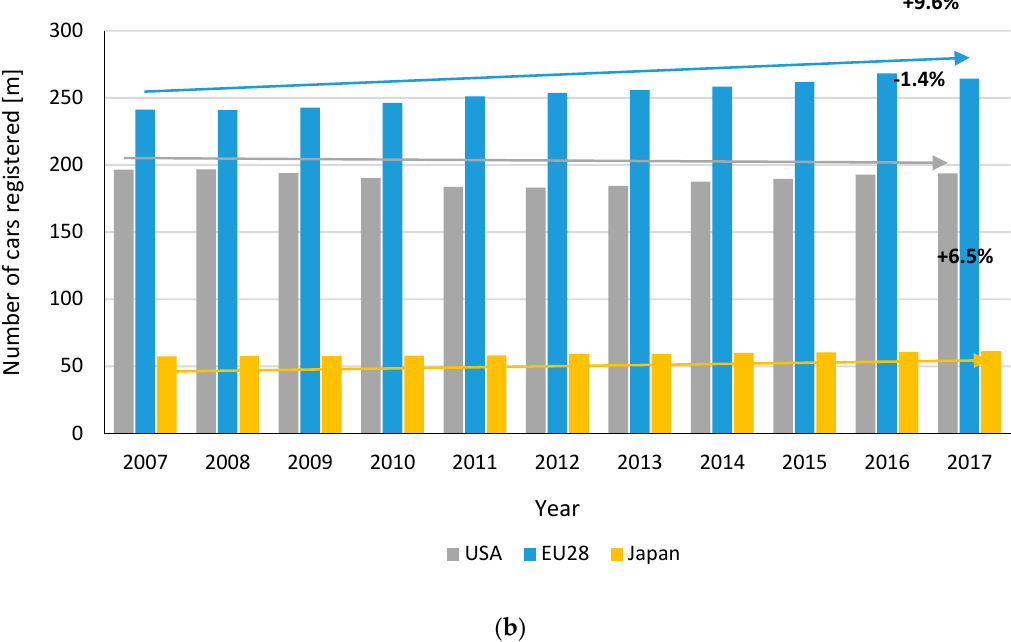
Figure 1. Motorization development in the analysed regions: ( a ) Population in the US, EU and Japan in 2007–2017 [m]; ( b ) Number of cars registered in the US, EU and Japan in 2007–2017 [m vehicles].